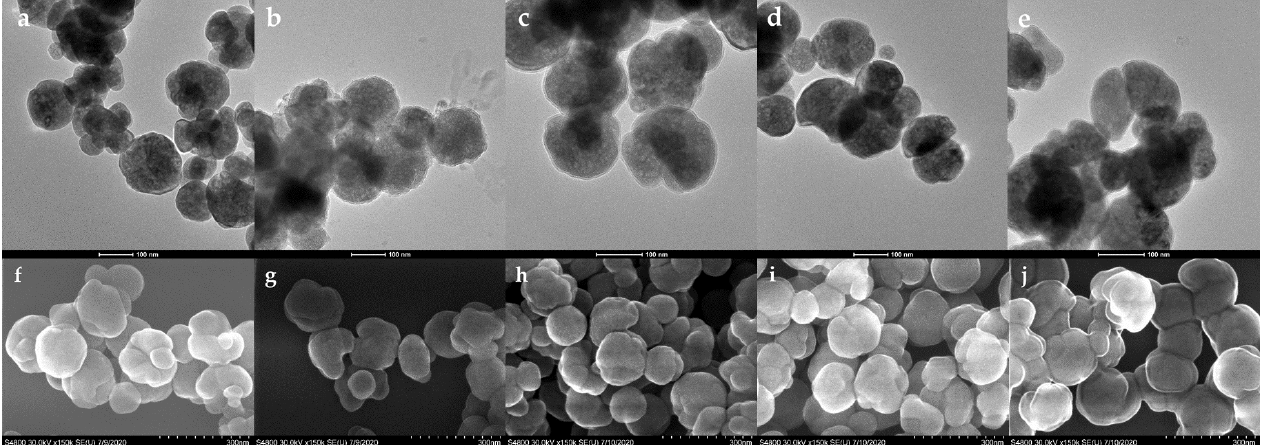
Figure 4. TEM and SEM images of the core–shell magnetic nanoparticles. ( a – e ) are TEM and ( f – j ) are SEM images of Fe 3 O 4 , Fe 3 O 4 @SiO 2 , Fe 3 O 4 @SiO 2 -NH 2 , Lys-PMNP and Lys-PMNP-TEMED, respectively.